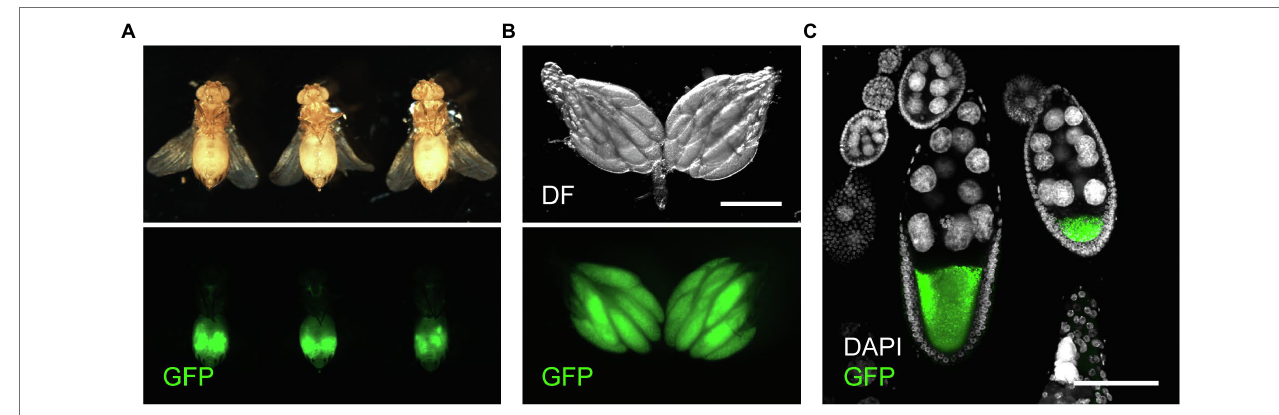
FIGURE 1 | GFP expression in Yp1::GFP female flies. (A) Ventral views of three representative Yp1::GFP female flies (upper panels) and respective ovaries (lower panels) observed under a fluorescent microscope. (B) Representative images showing GFP fluorescence in the ovary. Scale bar: 500 μ m. (C) Variabilities in the yolk accumulation levels in oocytes across ovarioles within a single ovary. Scale bar: 100 μ